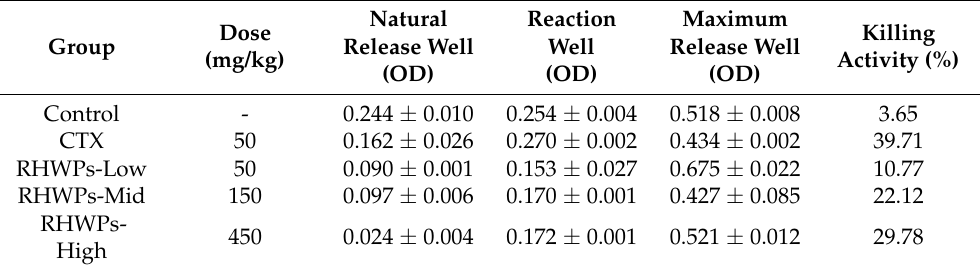
Table 7. Effect of RHWPs on tumor cell-killing activity of NK cells. (There is no significant differences